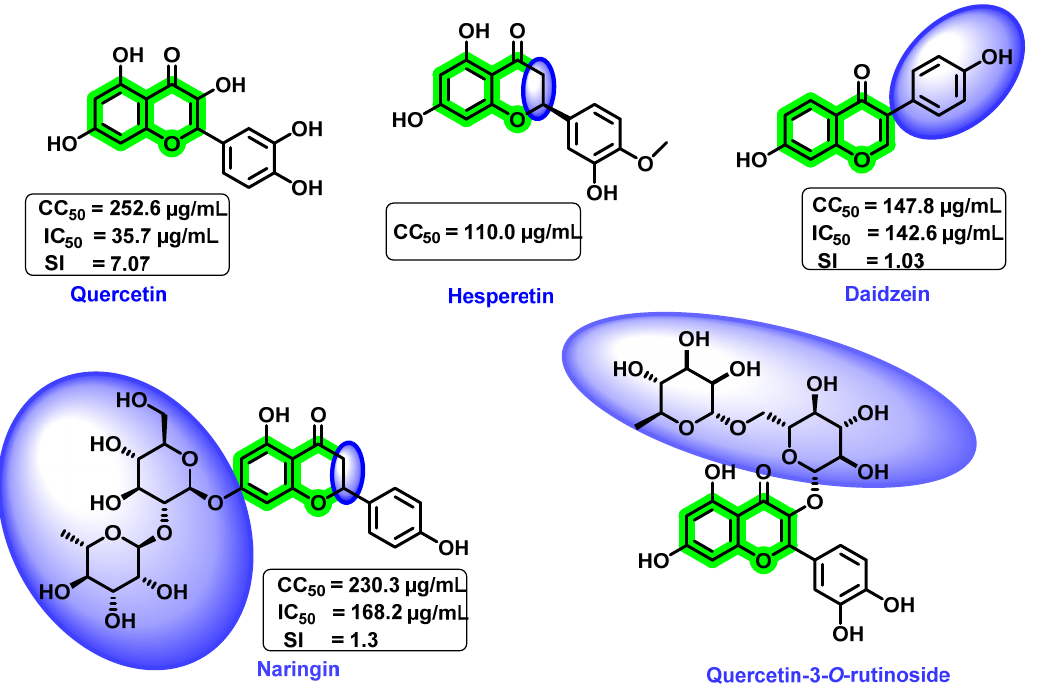
Figure 18. Examples of the effects of different substituent groups and their positions on the chromene nucleus. The blue highlighted area indicates the substituent group causes a reduction in anti-dengue virus activity.